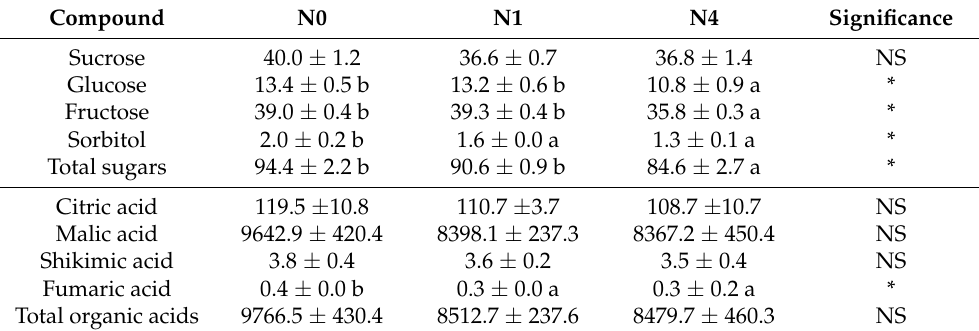
Table 2. Primary metabolites (sugars mg g − 1 FW; organic acids µ g g − 1 FW) of ‘Topaz’ apples subject to three urea